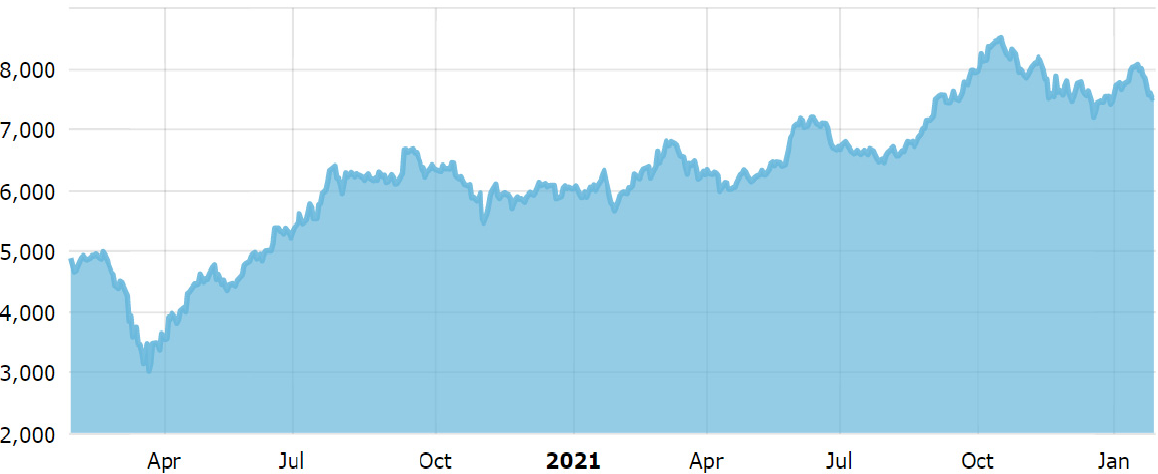
Figure 4. S&P BSE Energy Index Performance January 2020–January 2022. Source: https://www. bseindia.com/sensex/code/90 (accessed on 24 August 2022)